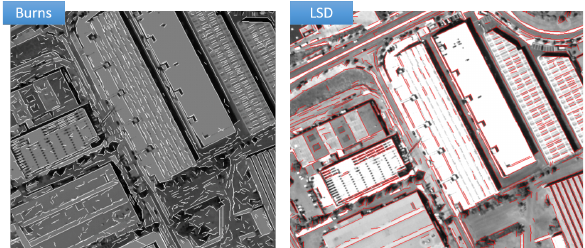
Figure 2. Comparison of line extraction method